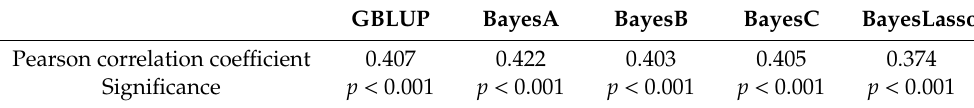
Table 4. Correlation test of phenotypic prediction at BW6 and observation at BW30.